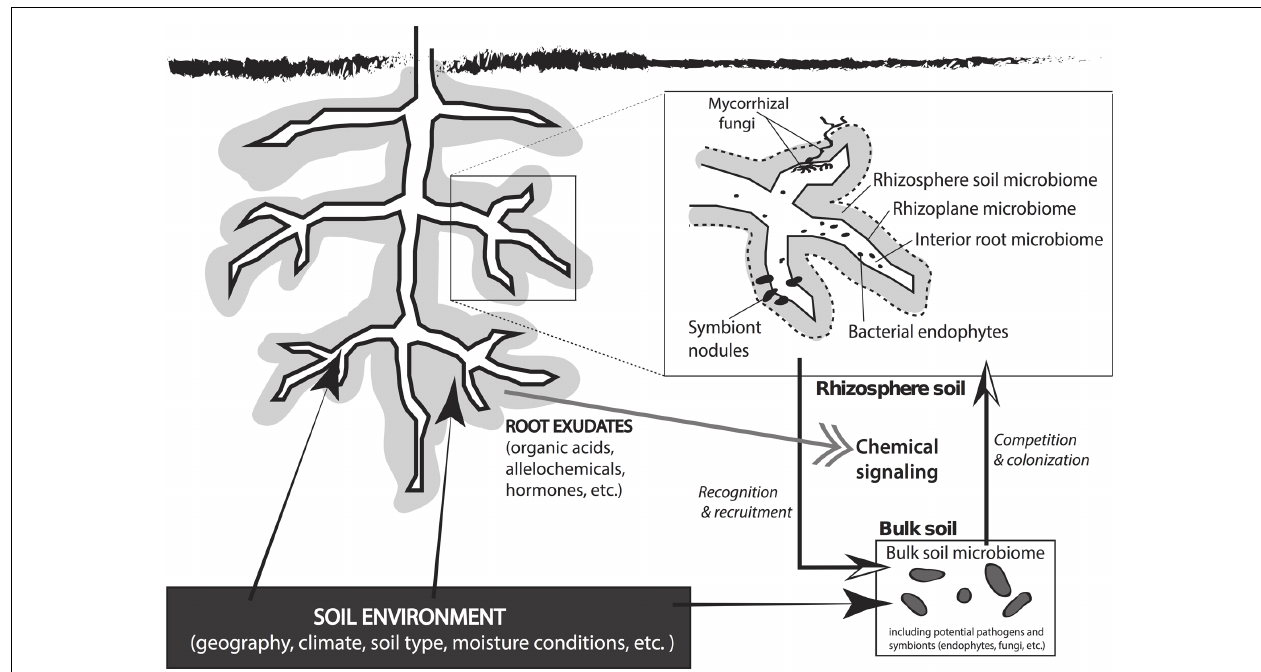
compete for space to colonize the rhizosphere, which results in a rhizosphere microbial community that is derived from the total microbial population in the bulk soil. The microenvironment in the rhizosphere includes the rhizosphere microbiome ( < 3–5 mm of the root), rhizoplane microbiome (at root–soil interface), and the interior root microbiome. Common symbiotic interactions in the root zone include mycorrhizal fungi, bacterial endophytes, and symbiont